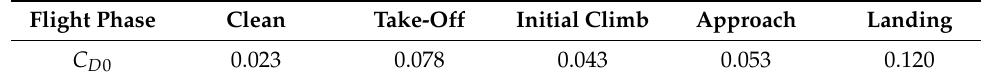
Table 3. Zero-lift drag values compiled using data from [44].